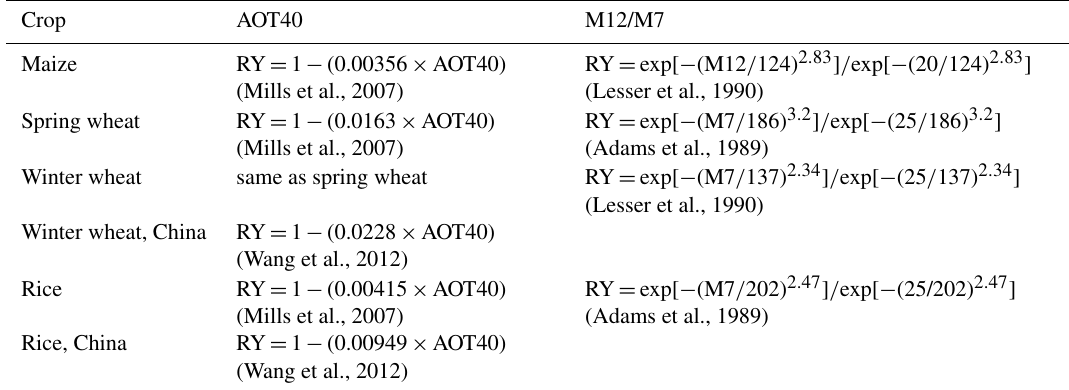
Figure 4. (top row) Planting dates and (bottom row) harvesting dates used in this study for (left column) maize, (middle column) wheat, and (right column) rice. Filtered for base crop production greater than 0.01Mgkm − 2 . Table 1. Relationships between ozone exposure metric and relative yield (RY) due to